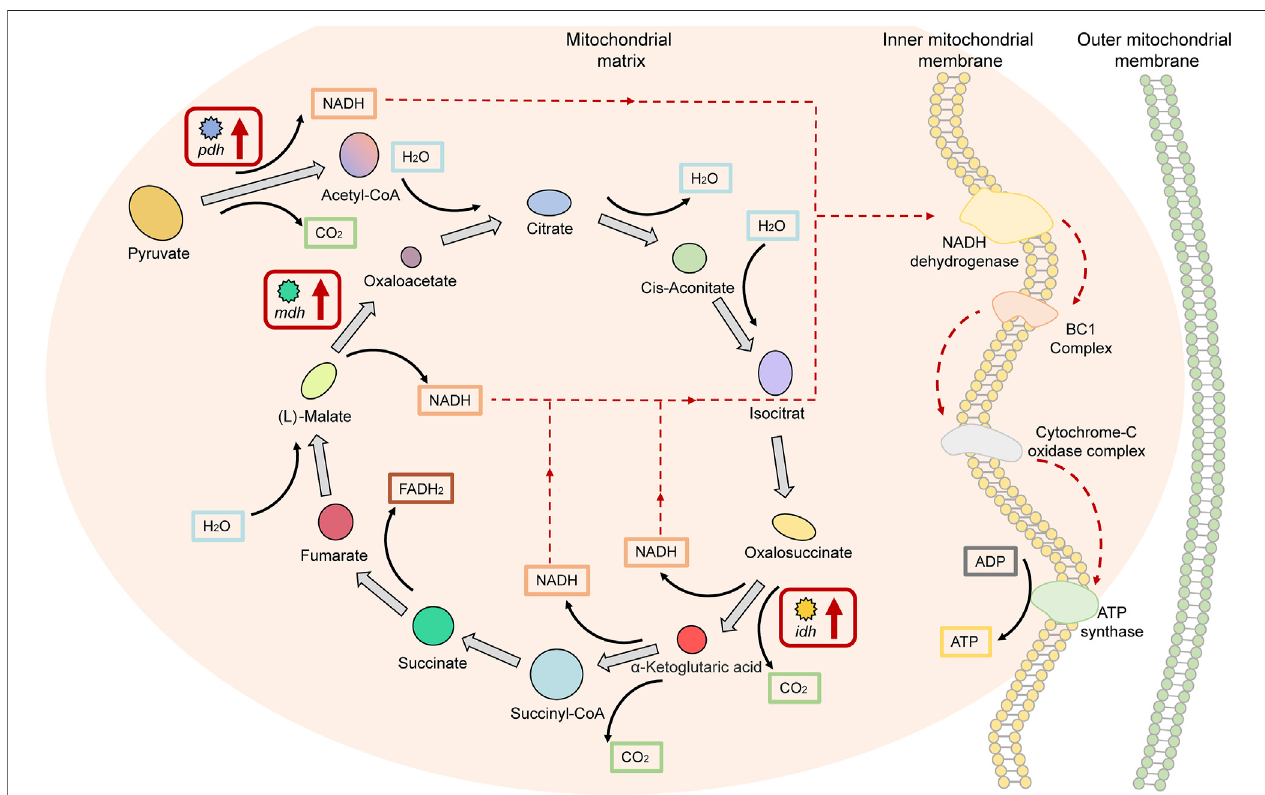
FIGURE 6 | Key factors of the “ tricarboxylic acid cycle (TCA cycle) signaling pathway ” in superior growth performance Nile tilapia. Red boxes denote upregulated genes. Genes encoding key enzymes ( phd , idh , and mdh ) in pathways involved in energy metabolism (NADH-ATP) were upregulated.